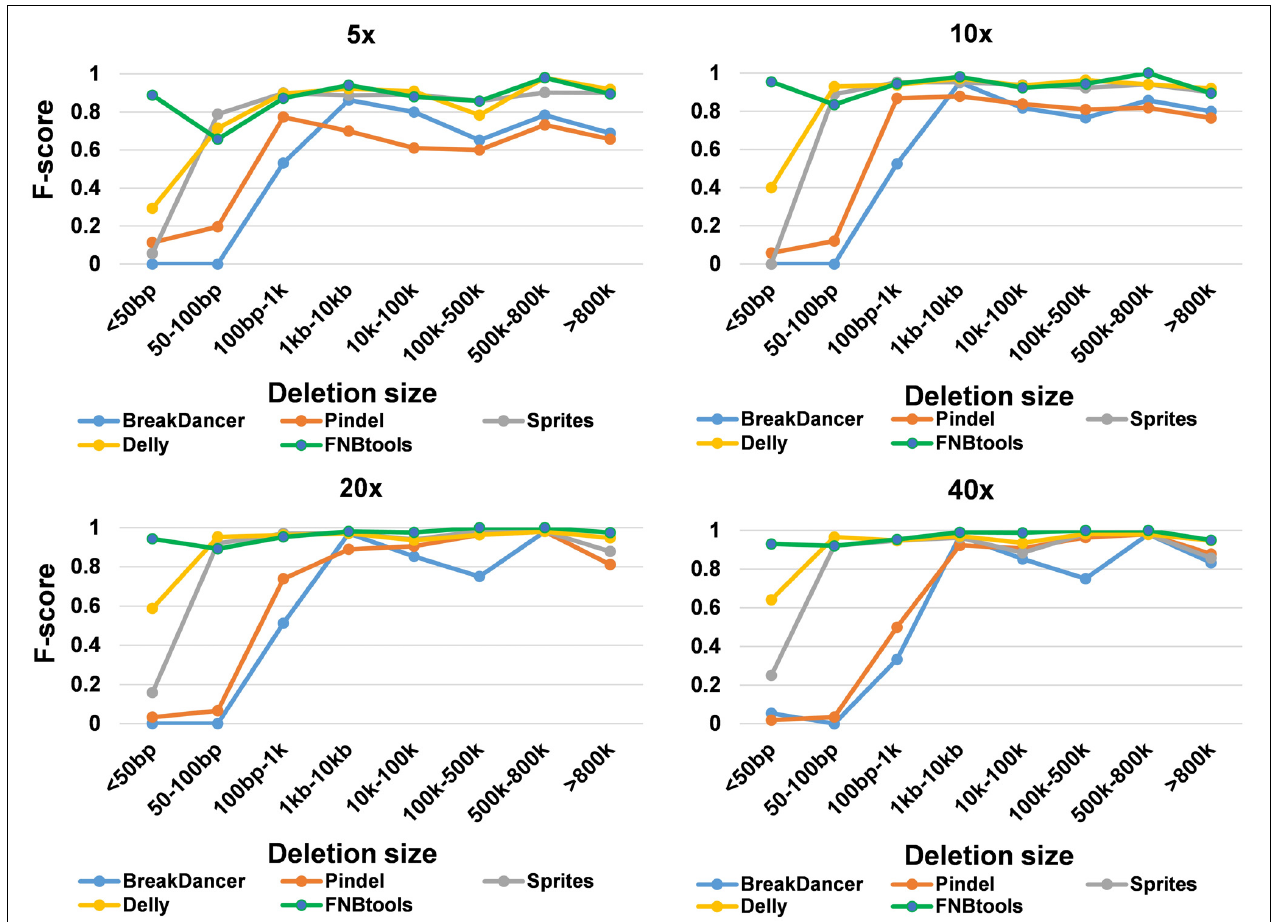
FIGURE 3 | Accuracy summary of five deletion callers with different coverage simulated